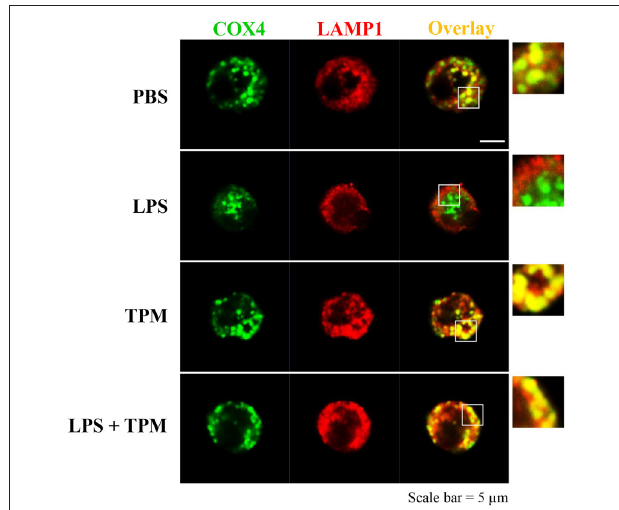
FIGURE 4 | TPM decreased the bacteria killing activity of LPS-primed neutrophils. (A) In vitro bacterial killing by neutrophils primed with LPS and/or TPM. Intra-cellular bacteria harvested from neutrophils were plated on agar plates, incubated overnight, and quantified as bacteria colony-forming units (CFU). (B) Relative bacterial killing rates were calculated according to the input control. Data represent three experiments. * p <